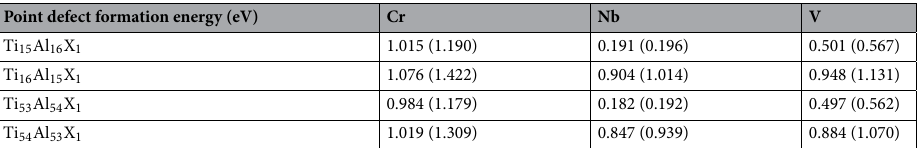
Table 1. Relaxed (without the parentheses) and unrelaxed (in the parentheses) point defect formation energies of each ternary alloy considering the substitution of a Ti or an Al site by an alloying element X (Cr, Nb, or V). Results for supercells with 32 and 108 atoms are